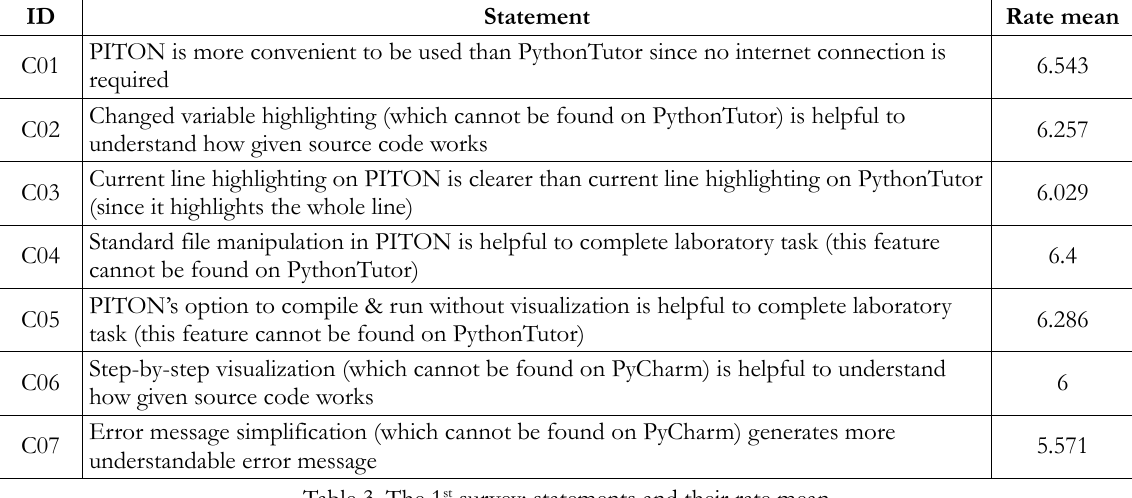
Table 3. The 1 st survey: statements and their rate mean